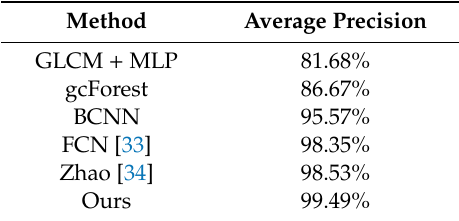
Table 1. Comparison of results on DAGM_2007 surface defect dataset.